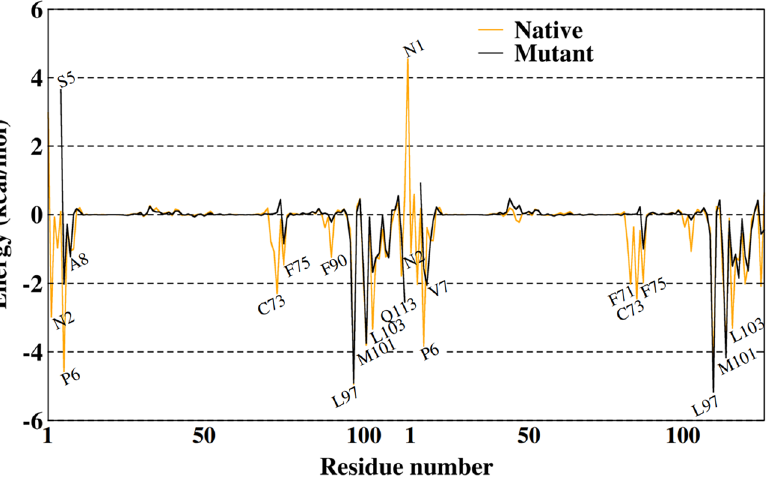
Figure 6. Decomposition of free energy per residue with the MMGBSA method with the energy contribution in terms of a hot spot for the